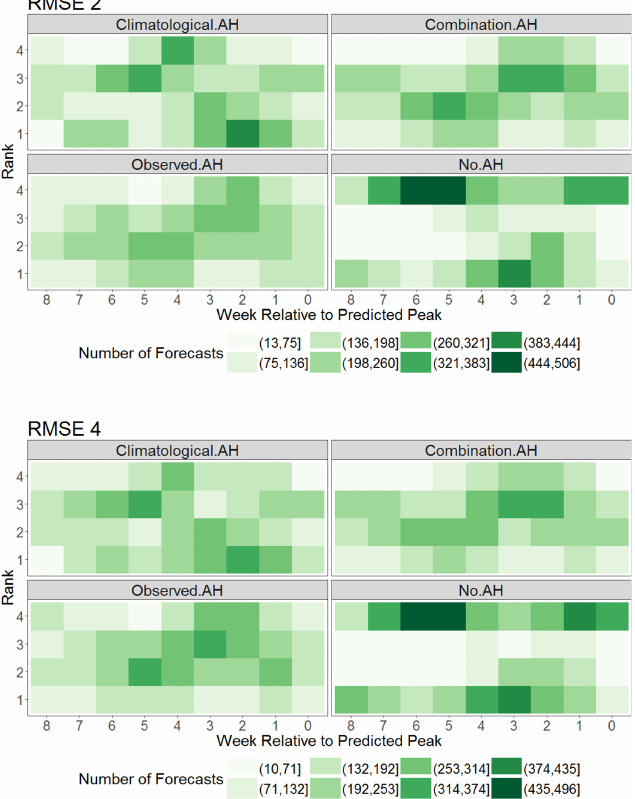
Fig 3. As for Fig 2, but showing RMSE of incidence for the first 2 weeks of forecast(top, RMSE 2) and the first 4 weeks (bottom, RMSE 4).